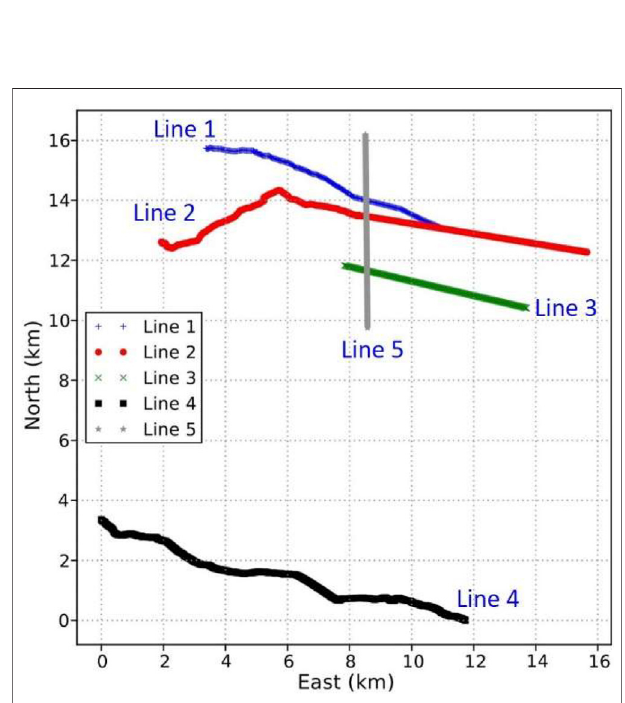
FIGURE 8 | Five 2D seismic survey lines at Pirouette Mountain and Eleven-Mile Canyon, Nevada, United States.